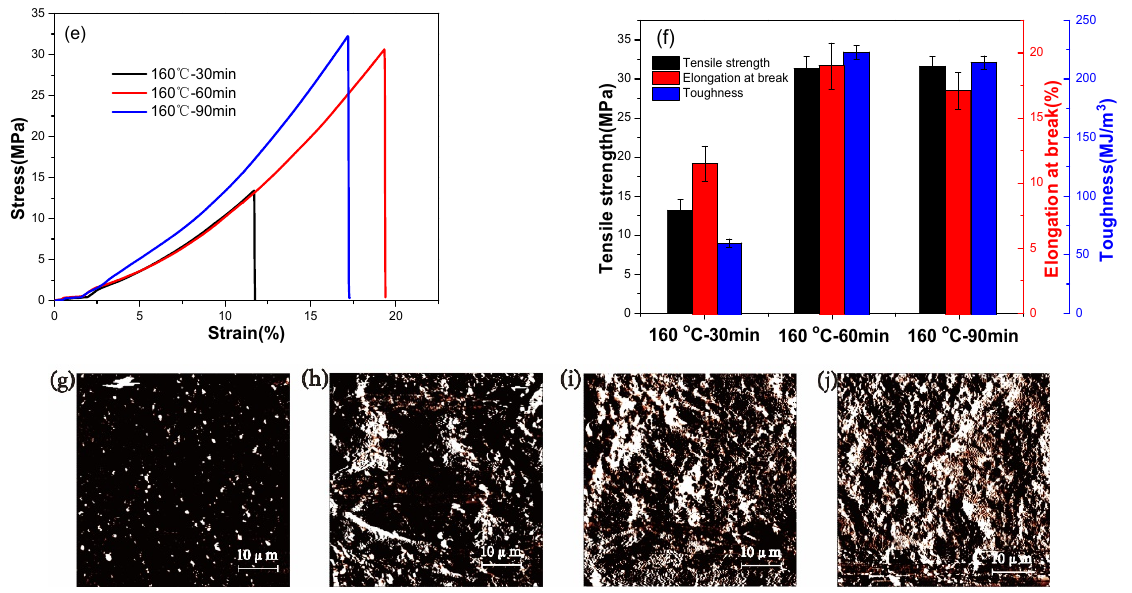
Figure 9. ( a ) Optical images of thermal recycling performance of 70%VPU OH by hot press, ( b ) FTIR spectra of the samples with different cycles of reprocessing, ( c ) Tensile curves and ( d ) Mechanical properties of the samples after different treating time at 160 ◦ C, ( e ) Tensile curves and ( f ) Mechanical properties of the samples for different cycles of reprocessing. AFM phase maps of ( g ) original, ( h ) first-time recycled, ( i ) second-time recycled, and ( j ) third-time recycled 70%VPU OH